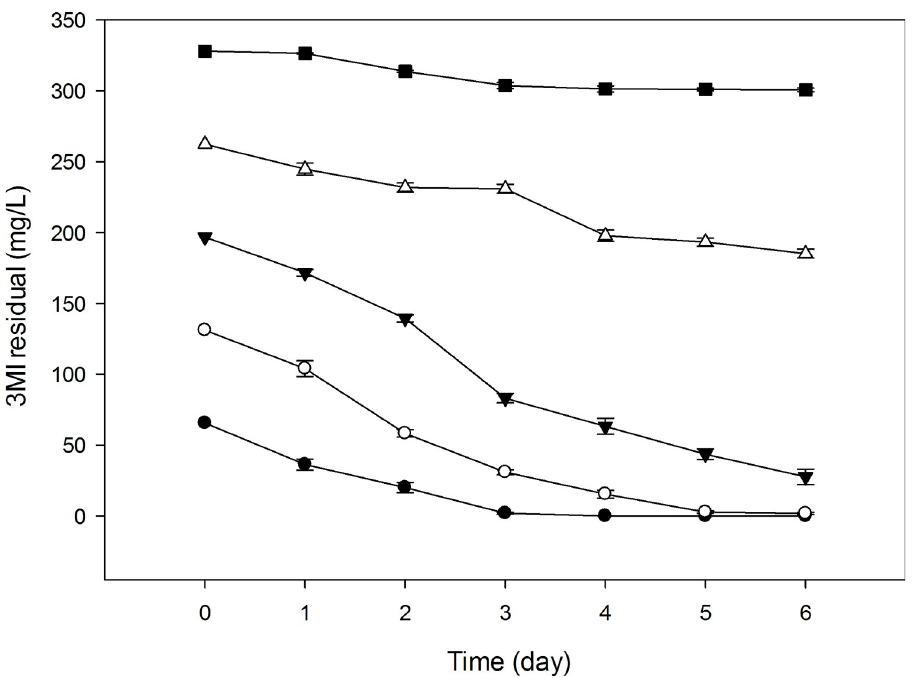
Fig 7. 3MI removal capability of NTA1-2A strain at different initial concentrations (mg/L). Symbols: solid circle, 65.58; open circle, 131.17; solid triangle, 196.75; open triangle, 262.34; solid square, 327.92; Error bars, mean ± SE of three riplicates; at T = 31˚C and pH 6.